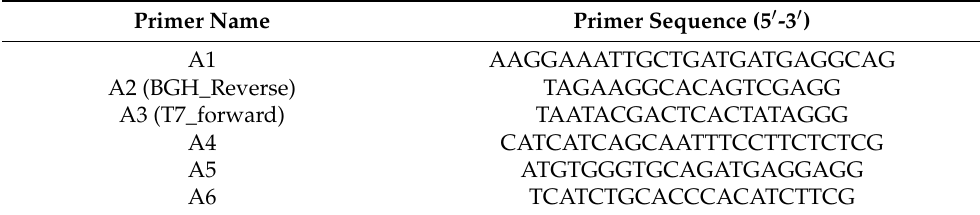
Table 1. List of primers used to generate Hsp90